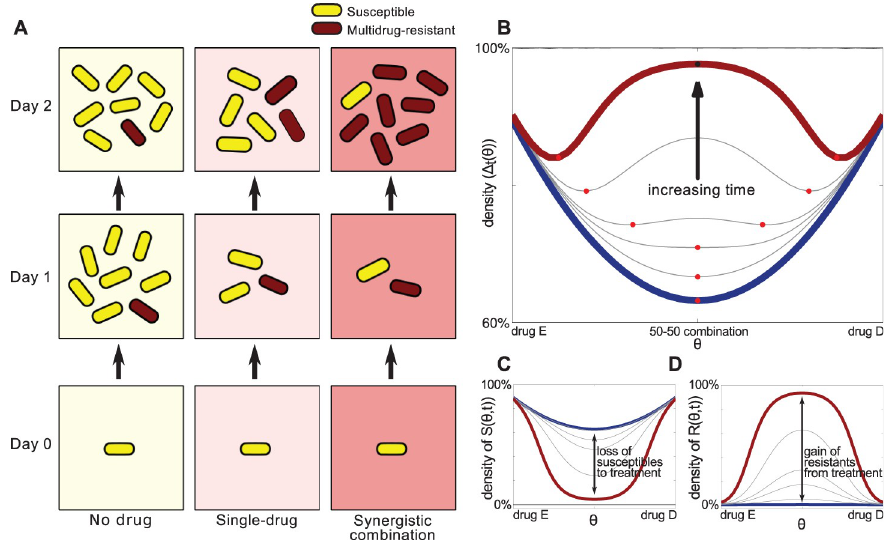
Fig 5. A figure from Pena-Miller et al showing (A) how a synergistic combination of antibiotics can be initially optimal, but produce maximal growth in the long-term. (B) When the combinations range from monotherapy with one drug, to a 50:50 split, to a monotherapy with the other drug, the initial ‘smile’ gets flipped to a ‘frown’ over time. Image reproduced under CC-BY 4.0 license, credit: